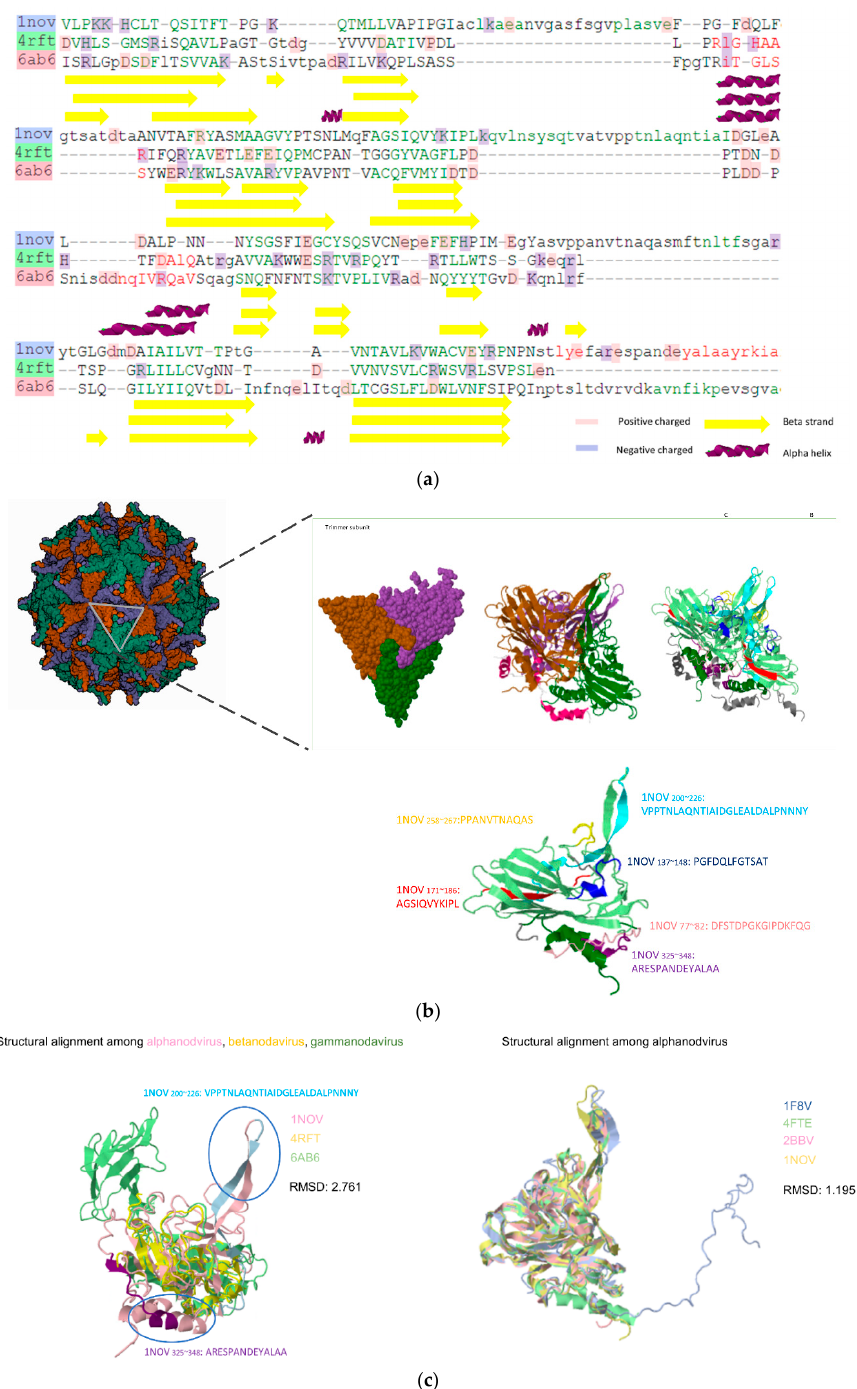
Figure 6. Summary of the icosahedral structure of alphanodavirus containing 180 subunits of the capsid protein. We chose a tangled subunit (PDB:1NOV) and a chain of this subunit to visualize the predicted epitopes using the spacefill and cartoon representation. ( a ) Sequence alignment of NNV S-domain in (subunit particles PDB:1NOV 6AB6; S-domain: 4RFT). ( b ) A subunit particle of alphanodavirus (PDB:1NOV) and a trimer P-domain model with ribbon and spacefill representation. Four predicted epitopes are represented using distinct color code from Figure 5a. ( c ) Two structure alignment trials of S-domain among: (left) alphanodavirus (PDB:1NOV), betanodavirus (PDB:4RFT), and gammanodavirus (PDB:6AB6); (right) alphanodavirus subfamily (PDB:1F8V, 4TFE, 2BBV, and 1NOV). Unique protrusion structure and part of predicted epitopes are